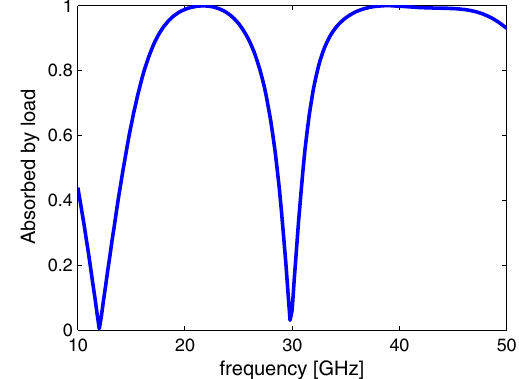
FIG. 8. Absorption curve of choke. Absorption in the load is given by